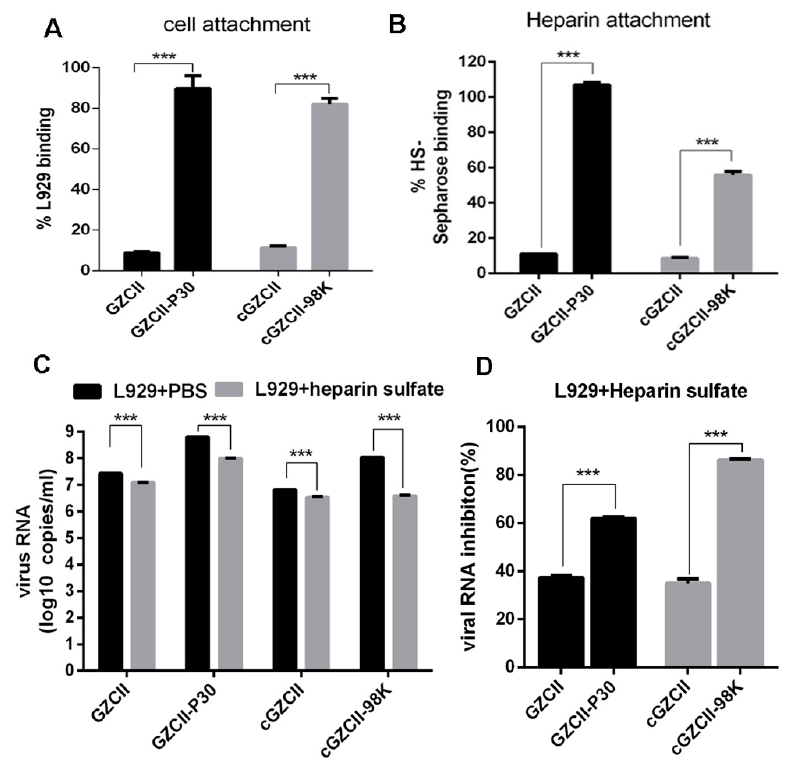
Figure 5. Characterization of the binding efficiency and sensitivity of EV71-GZCII variants to heparin sulfate (HS). ( A ) Viruses were incubated with detached L929 cells ( A ) or an HS-sepharose column ( B ) to allow attachment, and the ratio of adsorbed to input virus was determined by qPCR. Viruses pretreated with soluble HS sodium were used to infect L929 (MOI = 0.1), and the viral RNA copy numbers were determined at 24 h post-infection ( C ). The percentage of viral RNA change is shown in ( D ). (*: p < 0.05; **: p < 0.01; ***: p < 0.001).